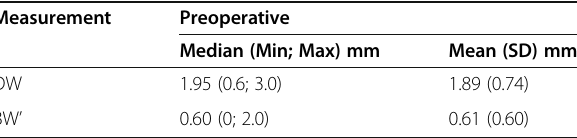
Table 3 Horizontal initial bone thickness (BW ’ ) and the gap distance between the extraction socket and implant (DW) at the preoperative stage